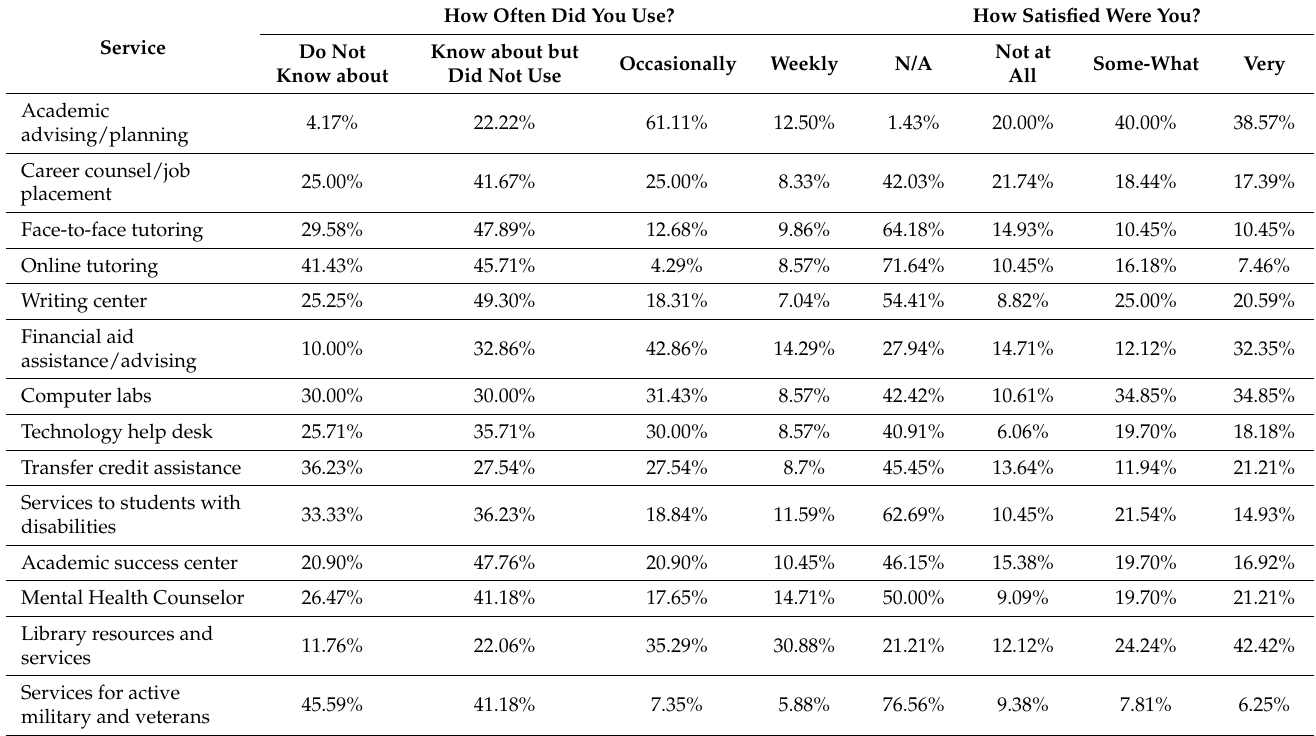
Table 7. Formal Social